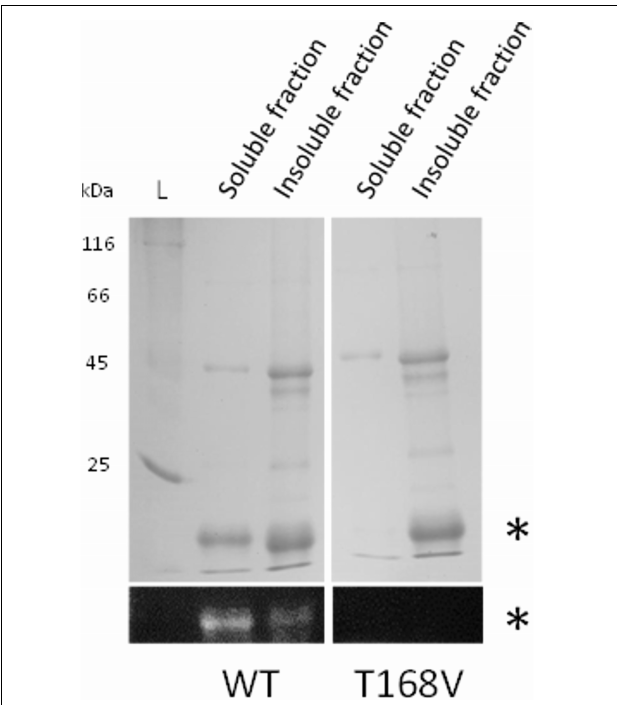
FIGURE 7 | Reconstitution of rFBD wild-type (WT) and threonine-168 variant (T168V). The top panels show Coomassie blue stained gels, while the bottom panels display the same gels under UV illumination. Stars indicate rFBD proteins. L, protein ladder.